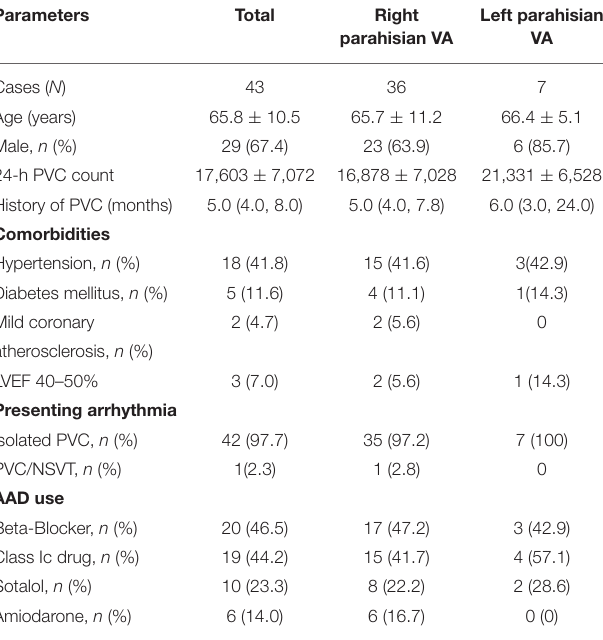
TABLE 1 | Patients’ baseline